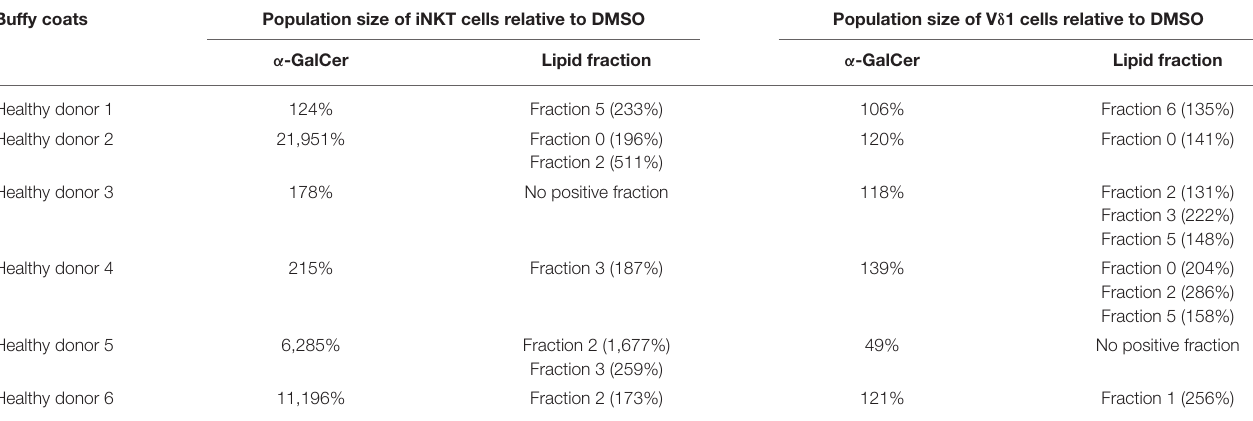
TABLE 1 | Lipid fractions of pediatric PRCC are able to induce proliferation of unconventional T cells. Buffy coats Population size of iNKT cells relative to